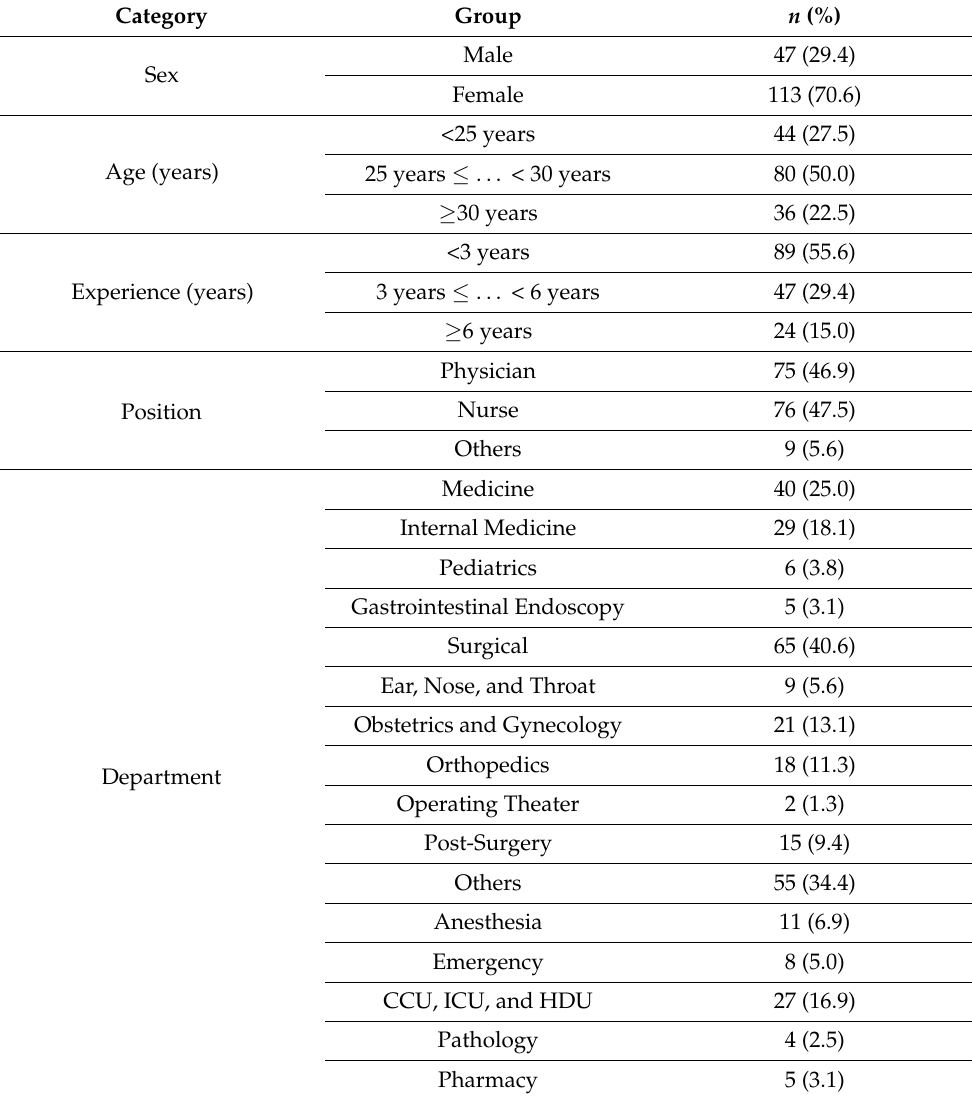
Table 1. Demographic characteristics of the participants ( n =